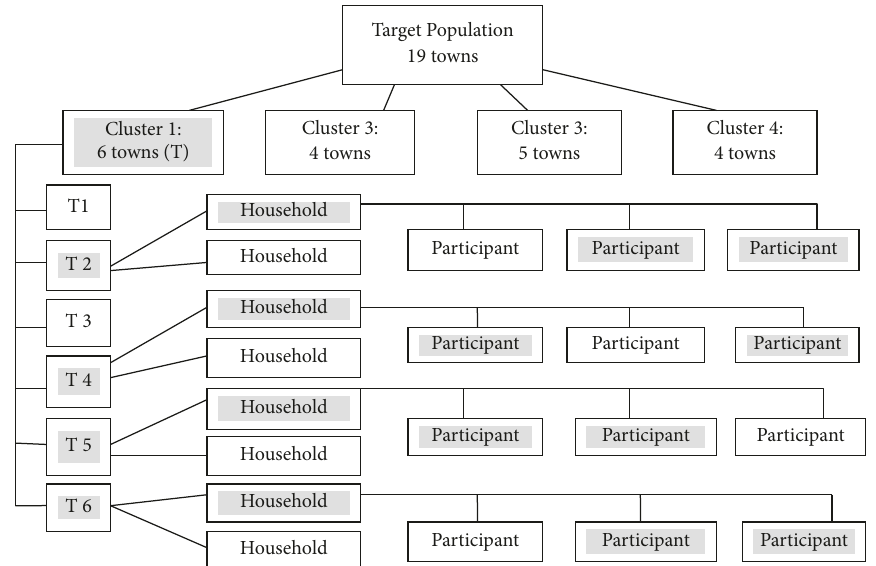
Figure 1: Flow chart of the sampling method. a Town (T) or community represents a smaller cluster selected from the bigger cluster. b A grey box shows that the box was selected to be